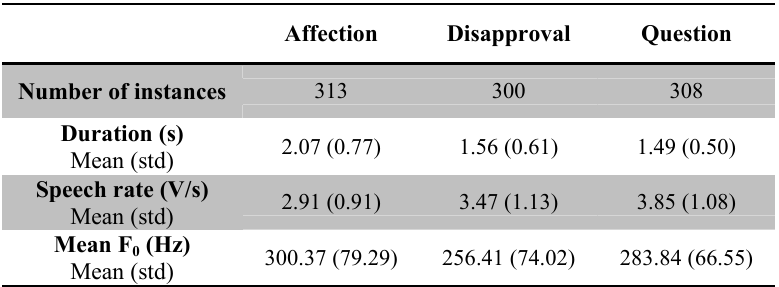
Table VII: Basic statistical information about the utterances grouped by interaction